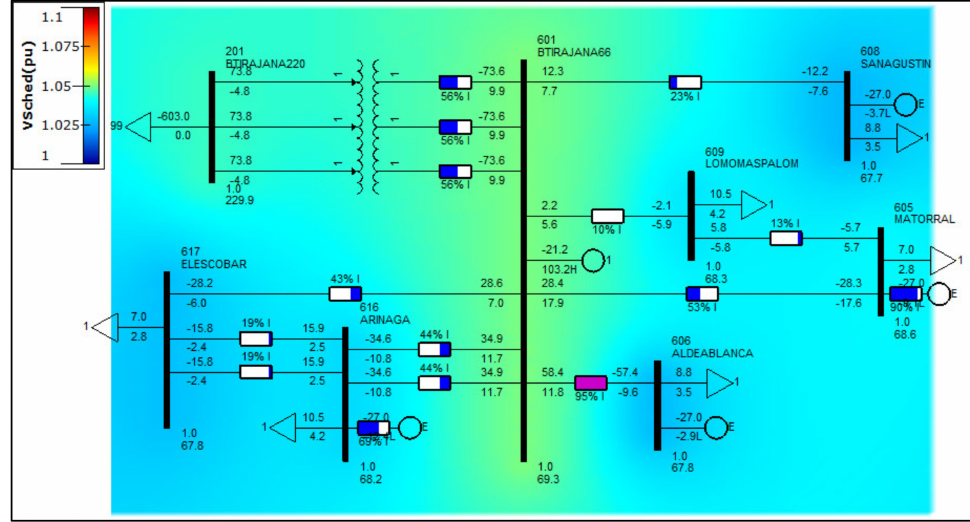
Figure 2. Power flow analysis in the Gran Canaria network. Table 3. Power system models considered in ARCWIND.